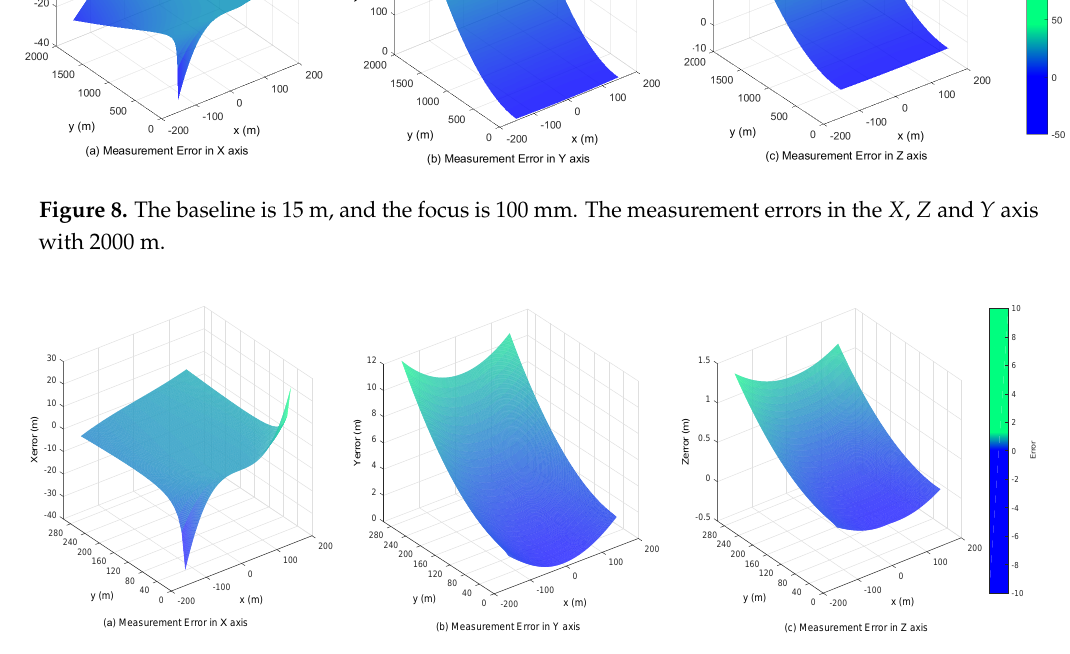
Figure 9. The baseline is 15 m, and the focus is 100 mm. The measurement errors in the X , Z and Y axis with 280 m.